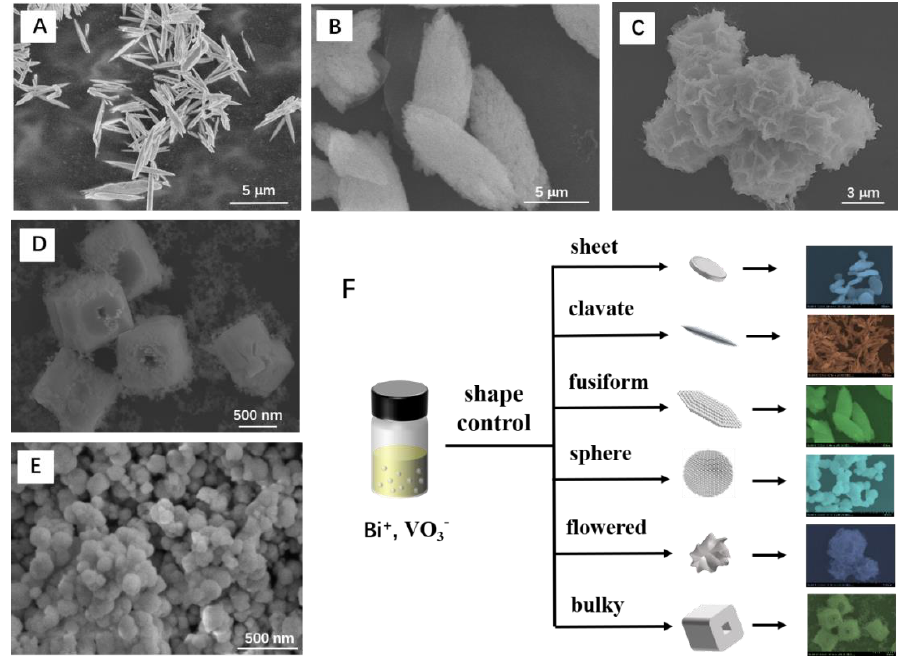
Figure 1. SEM images of BiVO 4 with selected morphology: ( A ) clavate, ( B ) fusiform, ( C ) flowered, ( D ) bulky, and ( E ) particle. ( F ) Schematic diagram of shape control of the bismuth vanadate. The selected BiVO 4 samples were characterized with a powder X-ray diffractometer (Figure 2A). Bulky BiVO 4 exhibited reflection planes (101), (200), (112), and (312) corresponding to the 2 θ values of 18.3°, 24.3°, 32.7°, and 48.4°, respectively. These values are well matched with standard JCPDS file No. 14-0133, illustrating a tetragonal phase of bulky BiVO 4 . The clavate BiVO 4 sample exhibited a tetragonal structure. Moreover, diffraction peaks of impurities (BiO 2 ) were observed in clavate BiVO 4 . Particle BiVO 4 exhibited sharp diffraction peaks at 18.6°, 28.6°, and 30.9°, which correspond to (101), (112), and (004) crystal planes, respectively (JCPDS file No. 48-0744). The fusiform morphological sample exhibited (011), (004), and (113) planes of orthorhombic structure as indicated by the 2 θ of 19.1°, 29.8°, and 33.1° (JCPDS file No. 12-0293). Notably, there were no clear diffraction peaks in the flowered BiVO 4 sample, indicating poor crystallization of the flowered BiVO 4 sample. Overall, the selected BiVO 4 samples exhibited different properties, which are summarized in Table 1. The surface chemical states of selected BiVO 4 samples were further investigated by XPS. As for the O 1s spectrum (Figure 2F), the peaks around 529.2 eV were clearly shown in particle, bulky, and flowered BiVO 4 samples, which could be attributed to the lattice oxygen (O 2 − ) in BiVO 4 [24]. High-resolution XPS spectra of O 1s after peak fitting were shown in Figure S3. The peak at 529.2 eV was not observed in clavate and fusiform BiVO 4 samples, while a new peak at 530.4 eV appeared, which could be ascribed to the lattice oxygen in bismuth oxide, suggesting the surface of clavate and fusiform BiVO 4 were oxidized. The existence of the surface oxide layer in clavate and fusiform BiVO 4 samples was further confirmed by high-resolution XPS spectra of Bi 4f (Figure 2E) and V 2p (Figure 2D). The Bi 4f of particle, bulky, and flowered BiVO 4 samples showed two characteristic peaks at 164.8 eV and 159.1 eV that were attributed to Bi 4f 5/2 and Bi 4f 7/2 , respectively. The Bi 4f of clavate and fusiform BiVO 4 samples showed an apparent shift to high binding energy, attributed to the bismuth oxide. A similar phenomenon could be observed in the